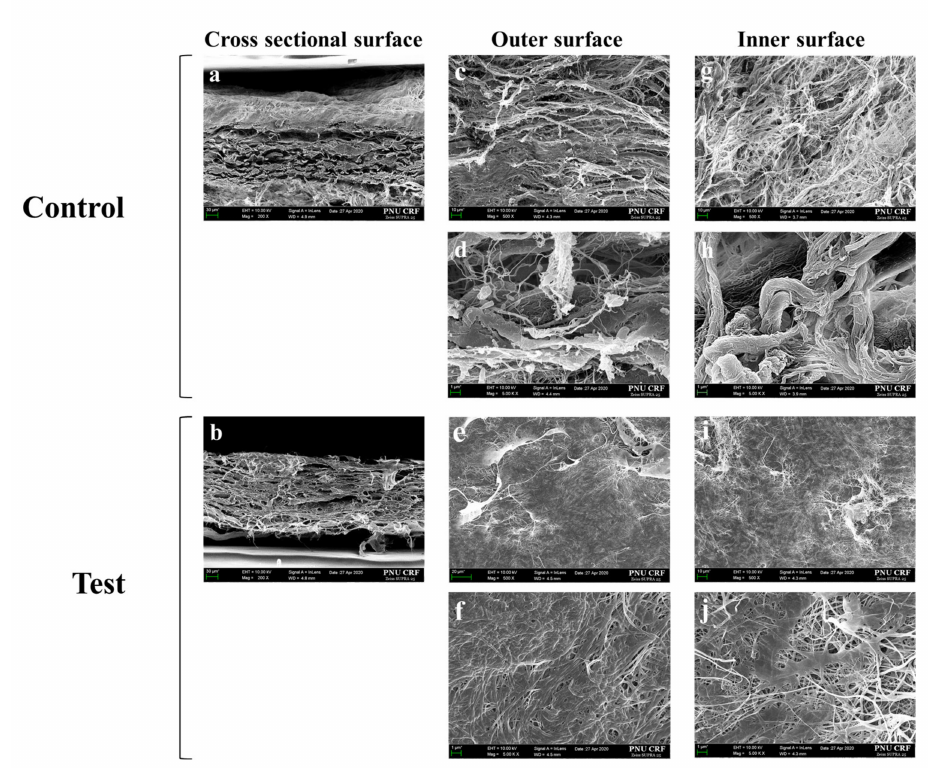
Figure 3. FE-SEM images of both membranes in three directions. ( a , c , d , g , h ) Non-cross-linked membrane; ( b , e , f , i , j ) cross-linked membrane. ( a , b ) Cross-sectional surface images; ( c , d , e , f ) outer surface images; ( g , h , i , j ) inner surface image. Original magnifications: × 200 ( a , b ); × 500 ( c , e , g , i ); × 5000 ( d , f , h , j ). Control is represented by non-cross-linked collagen membrane; Test is represented by EDC-cross-linked collagen